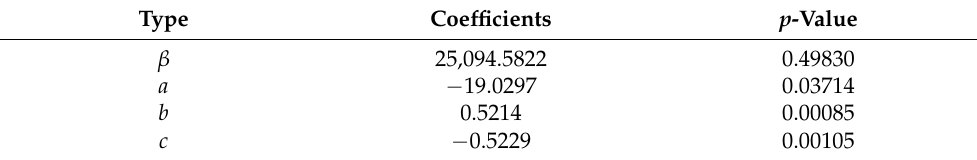
Table 4. Regression equation parameters for the changes in the groundwater storage